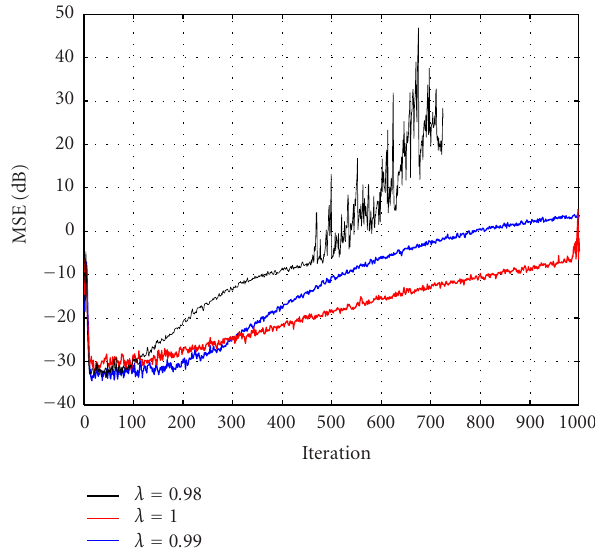
Figure 3: A lattice section in array form.